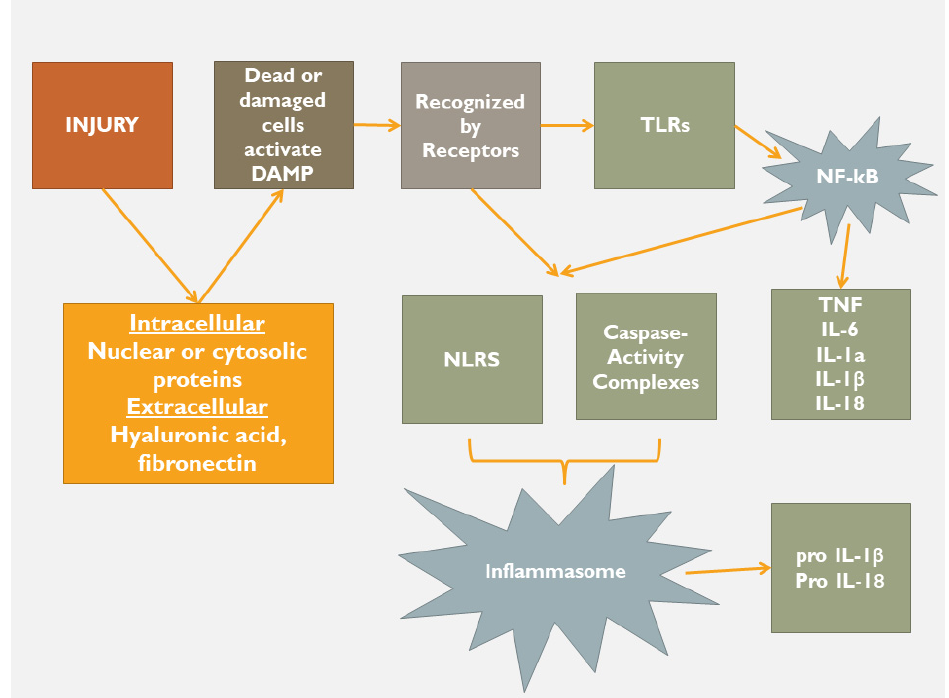
Figure 3. Mechanisms and mediators involved in sterile inflammation (DAMP—damage-associated molecular patterns, TLRs—Toll-like receptors; NF-kB—nuclear factor kappa-beta; NLRs— NOD-like receptors; IL—interleukin).